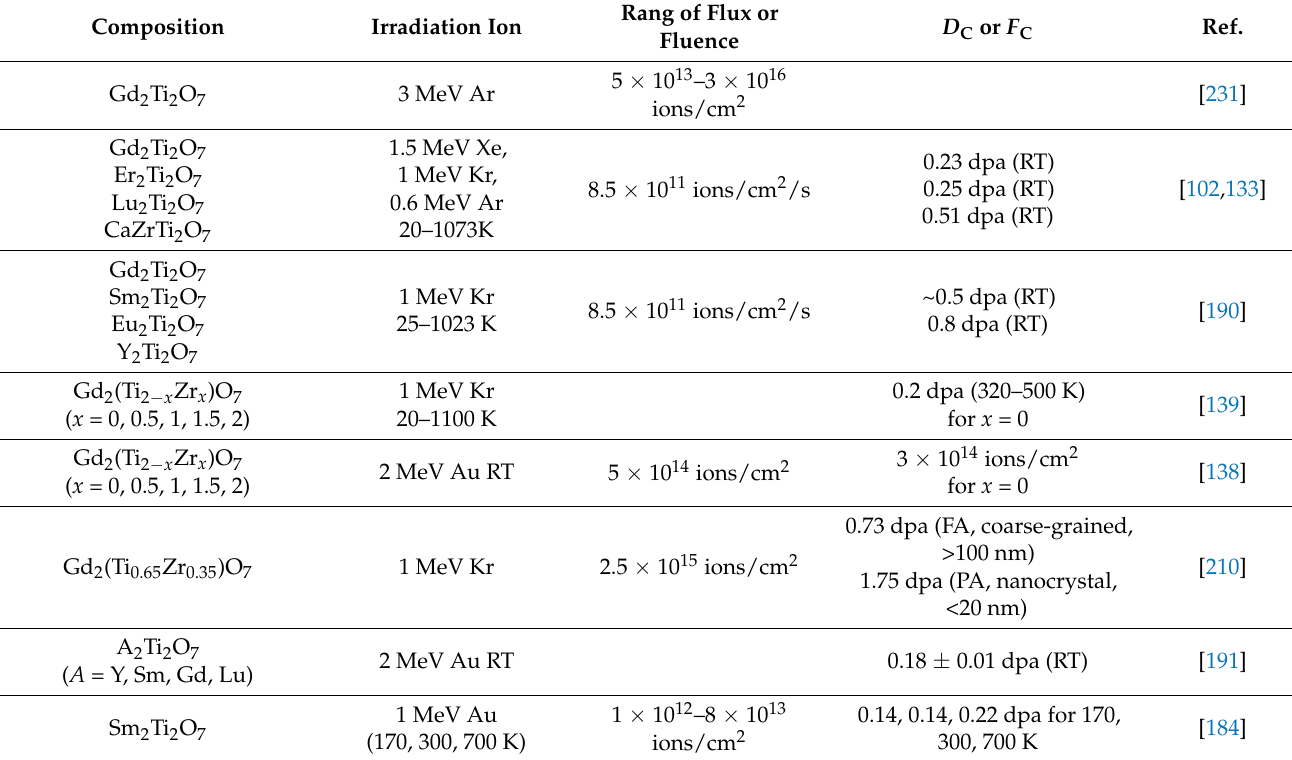
Table A1. Summary of publications of pyrochlore